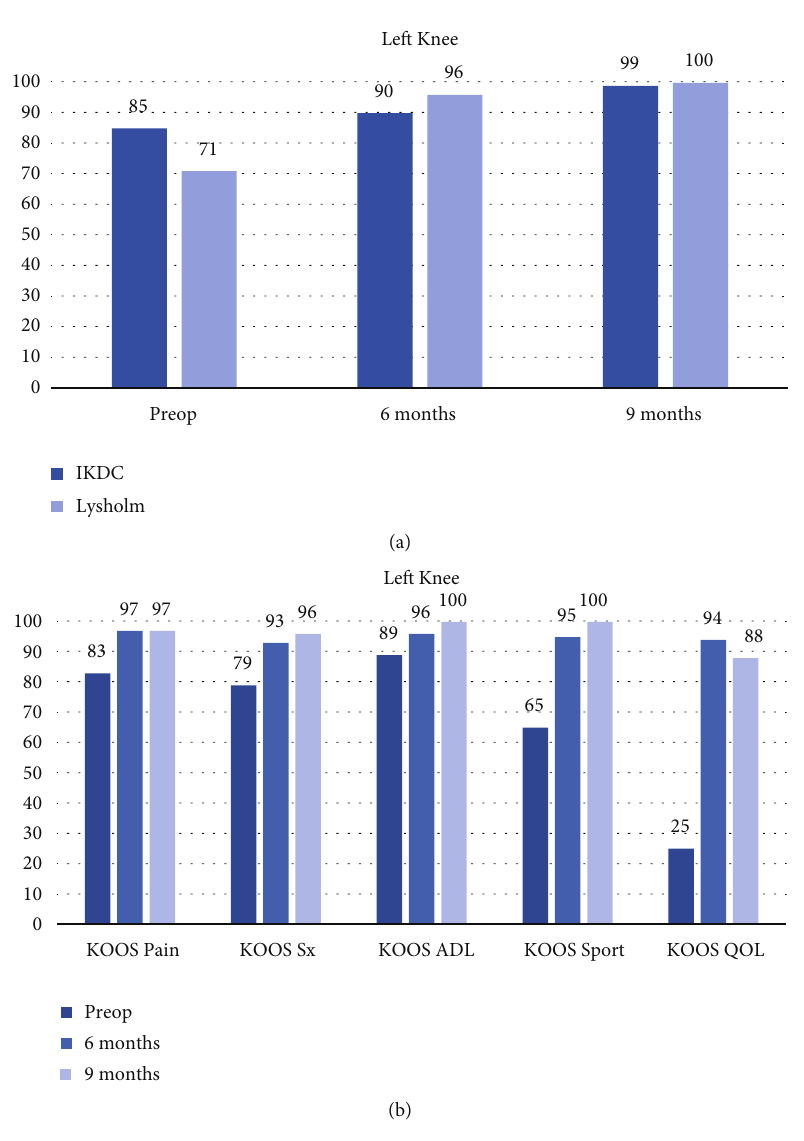
Figure 15: (a) Left knee IKDC and Lysholm. (b) Left knee KOOS.